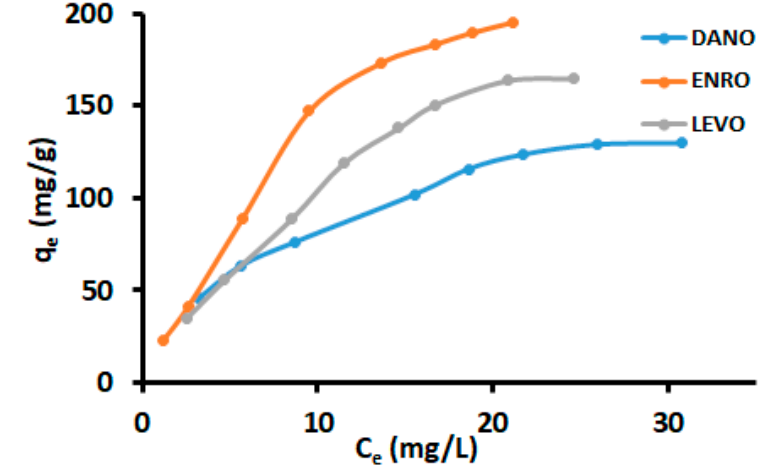
Figure 8. Sorption isotherms—modeling with Langmuir, Freundlich, Sips and Hill (MA: 34 mg; ± 3 ◦ sonication time: 25 min; pH 7; temperature: 25 ± 3 °C). sonication time: 25 min; pH 7; temperature: 25